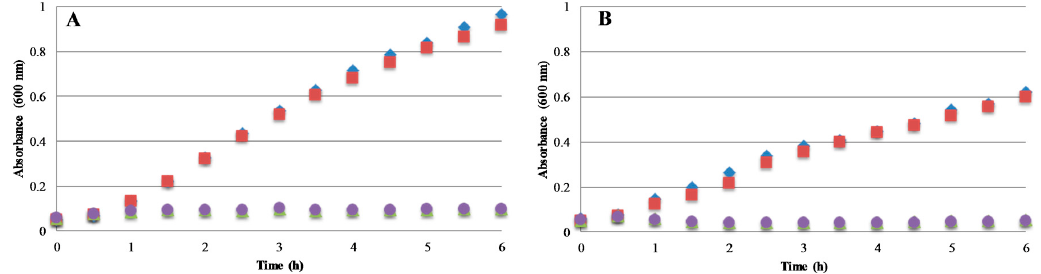
Figure 5. Antibacterial activity of Ag x O coatings in liquid culture. Absorbance (i.e., optical density at 600 nm (OD 600 )) is a measure of the number of bacterial cells in the solution. Ti or Ti discs coated with Ag x O were added to cultures of ( A ) S. aureus (starting density between 4 × 10 6 and 4 × 10 7 CFU/mL); or ( B ) E. coli (starting density ~3.73 × 10 7 CFU/mL). Symbols are (green ▲ , purple ● ) for Ag x O-coated discs, (blue ♦ ) for untreated control, and (red ■ ) for uncoated Ti disc control. Experiments were performed at 37 °C with constant shaking of the cultures except during OD measurement.